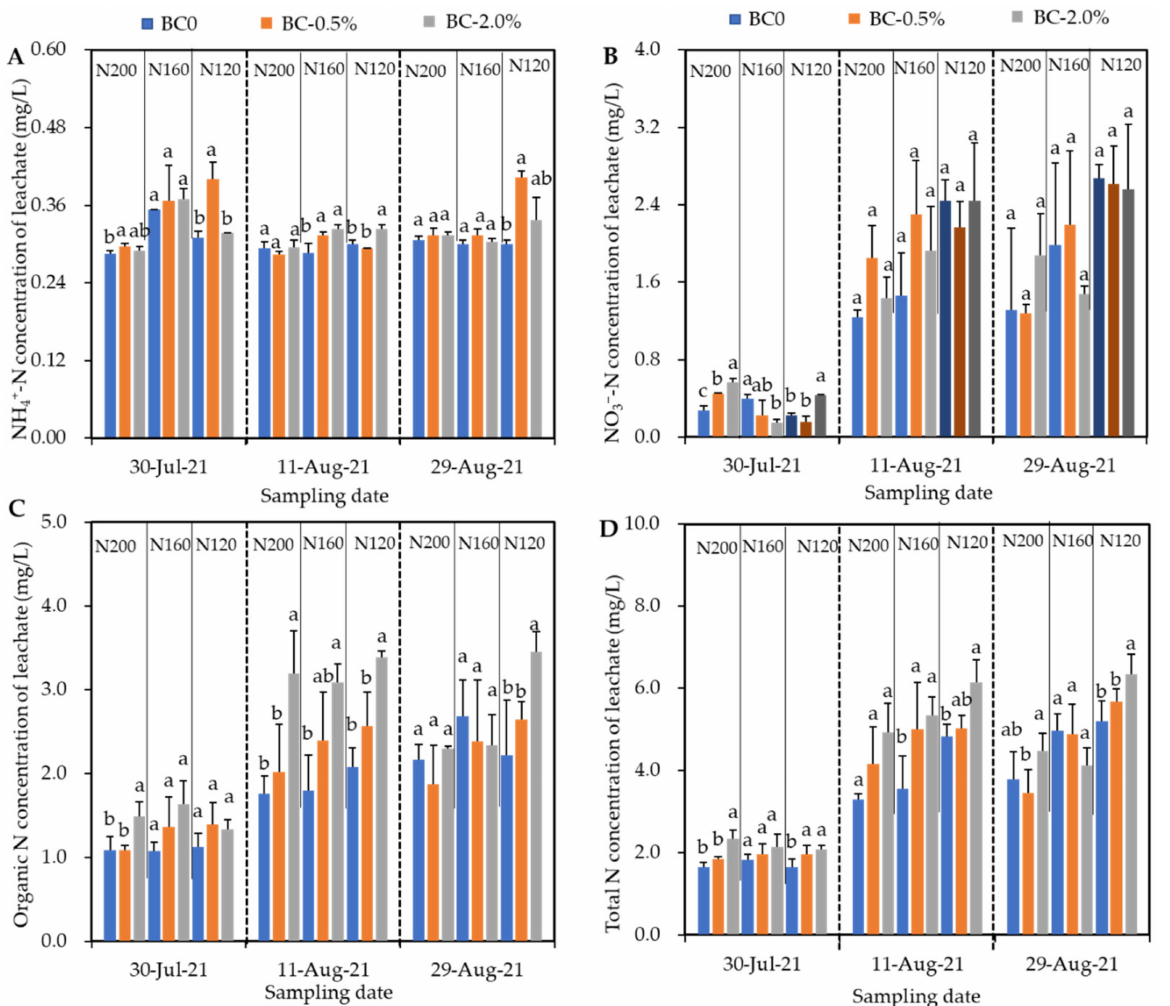
Figure 3. The NH 4+ -N ( A ), NO 3 − -N ( B ), organic ( C ) and total N ( D ) of leachate sampled at three observations on 30 July, 11 and 29 August 2021. Error bars represent the SD of the mean of three replicates. Different (same) letters above column chart indicate the differences between each treatment with same N input were (not) statistically significant, according to Duncan’s post hoc test at level of p <